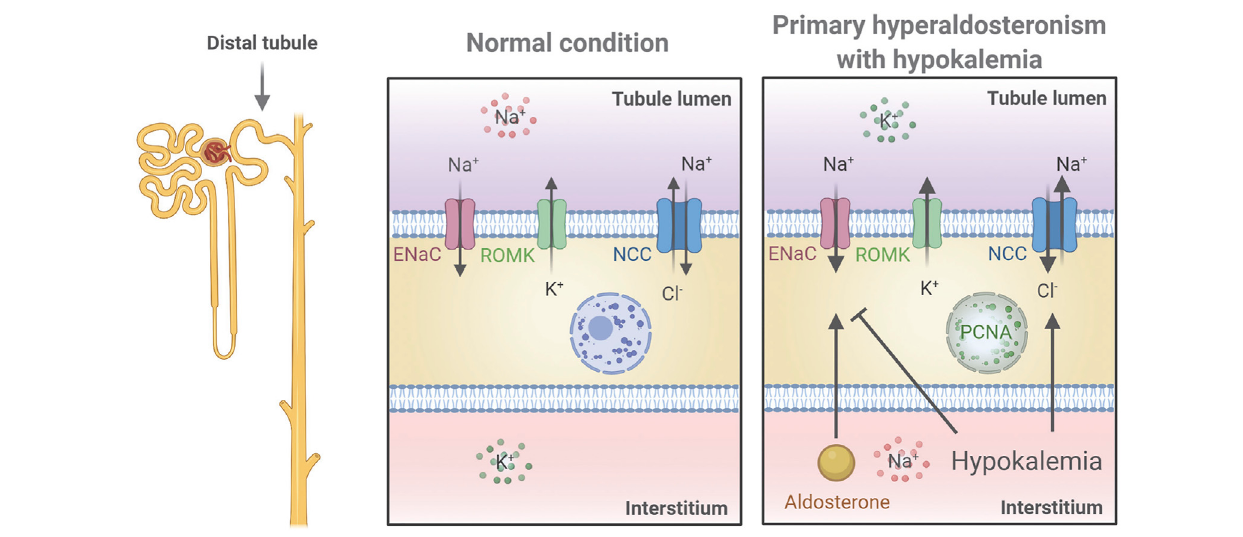
FIGURE 6 | Proposed mechanistic regulation of NCC and ENaC in the renal distal tubule in a mouse model of primary hyperaldosteronism associated with hypokalemia. Aldosterone stimulates ENaC to increase Na + reabsorption thus promoting K + secretion via ROMK leading to hypokalemia. Hypokalemia stimulates NCC and furthermore works as negative feedback to aldosterone by inhibiting ENaC. Finally, increased plasma aldosterone increases PCNA in the nucleus indicating cell proliferation, but whether this occurs directly or indirectly via stimulation of DCT cells was not determined. The fi gure was created with BioRender.com.